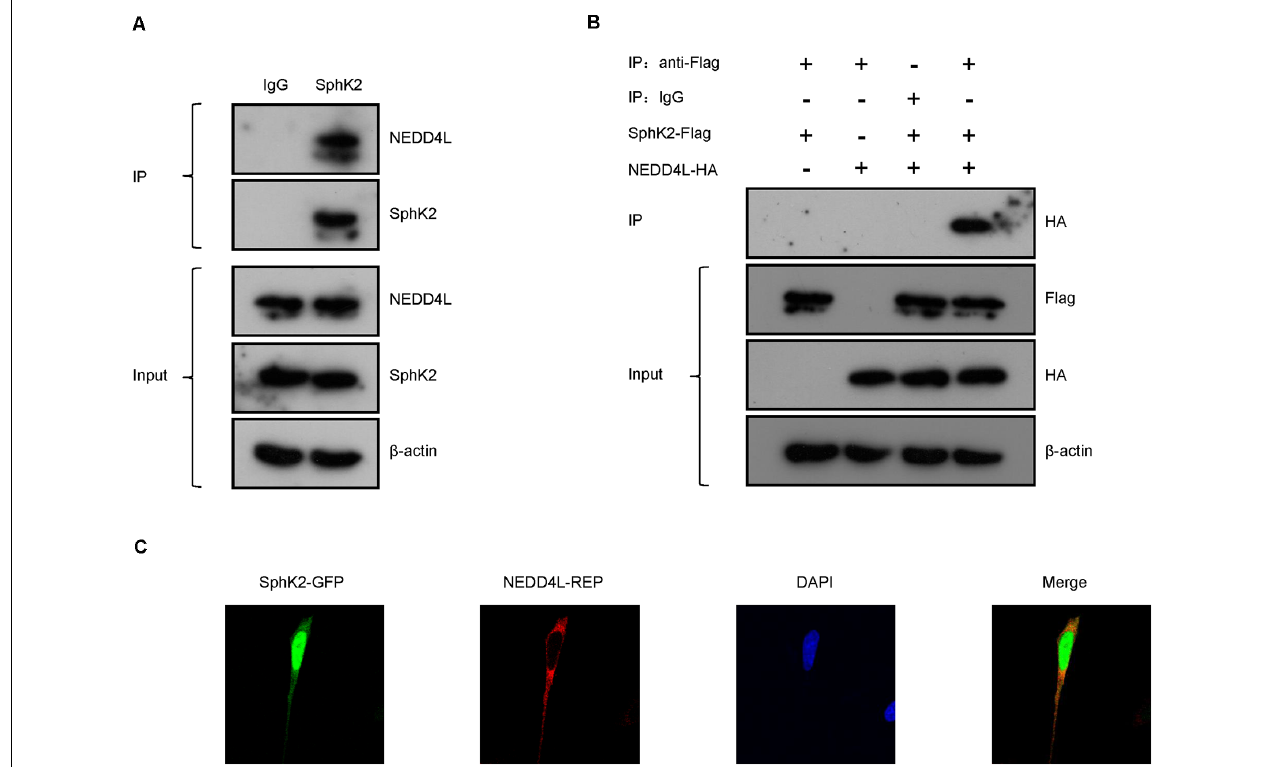
FIGURE 2 | NEDD4L interacts with SphK2. (A) Anti-SphK2 was used to precipitate the protein complexes in HEK293T cells and anti-NEDD4L was used to perform co-IP assay. (B) HEK293T cells were transfected with SphK2-Flag and/or NEDD4L-HA overexpression plasmid. Anti-Flag was used to precipitate the protein complexes and anti-HA was used to perform the co-IP assay. (C) Fluorescence co-localization assay was used to confirm that NEDD4L was co-expressed with SphK2 in the cytoplasm in HEK293T cells.